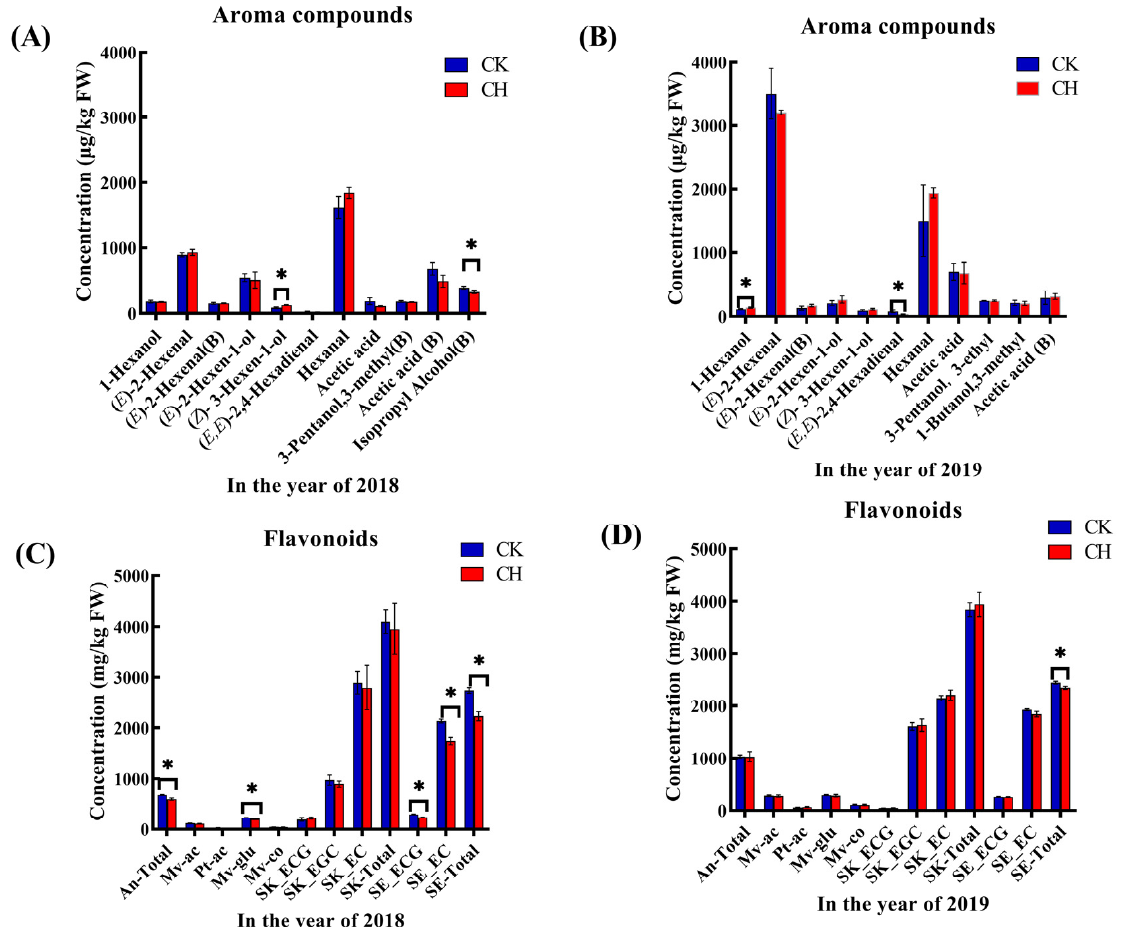
Figure 4. Effects of covering peanuts on the concentrations of the marker aroma compounds and flavonoids in the mature grapes in 2018 and 2019. The marker aroma compounds in 2018 ( A ) and 2019 ( B ); marker flavonoids in 2018 ( C ) and 2019 ( D ). Data in bar plots are expressed as mean ± standard error (n = 3). * indicates significant differences based on Duncan’s test at p < 0.05.